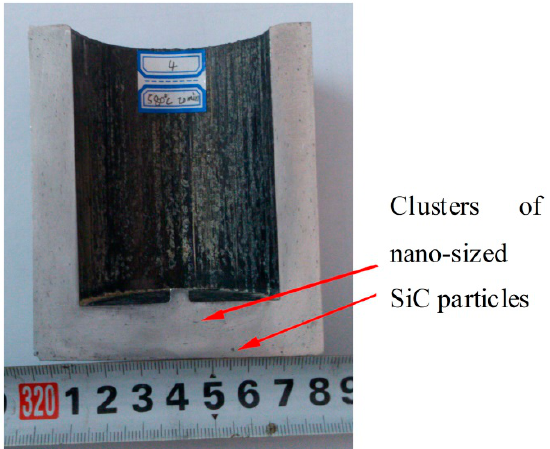
Figure 4. Half-sectional macrograph of the thixoformed part of the nano-sized SiCp/7075 composite.